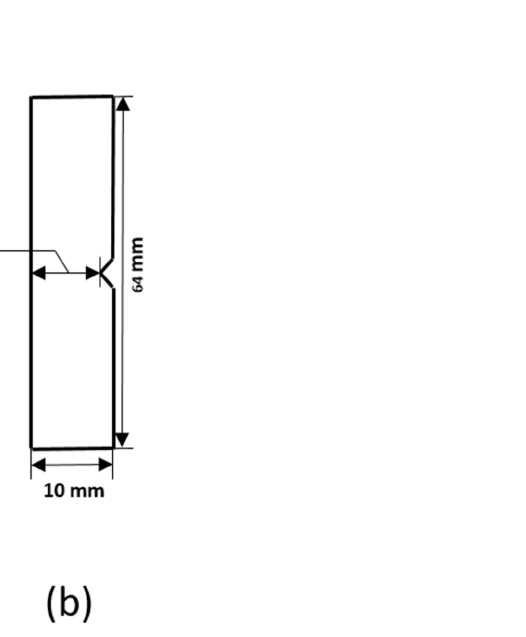
Figure 1. The geometry of samples for different toughness testing method: ( a ) EWF test, ( b ) dynamic test.